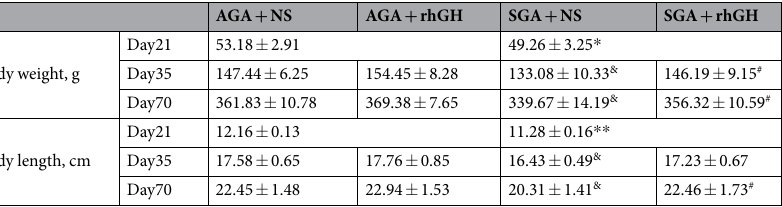
Table 1. The body weight and body length before and after GH or NS treatment. ANOVO: Results are expressed as the mean ± S.E.M. Statistical differences between the groups are given as follows: * p < 0.05: AGA vs SGA; ** p < 0.01: AGA vs SGA; & p < 0.05: AGA + NS vs AGA + rhGH; # p < 0.05: SGA + NS vs SGA + rhGH . n = 8 per experimental